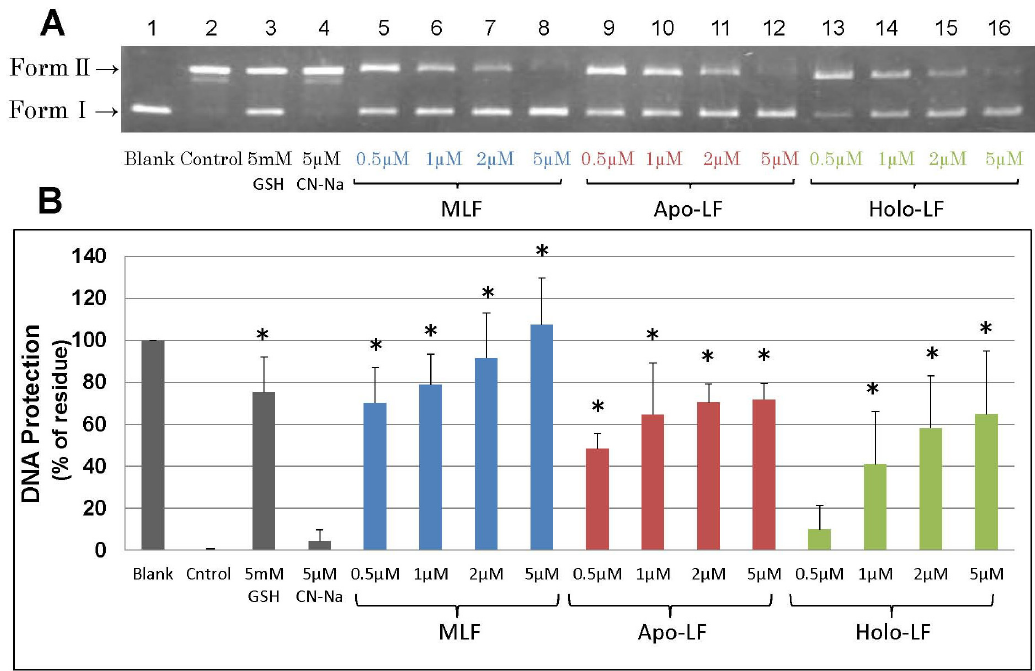
Figure 1. Dose response and efficacy of LFs on DNA damage by •OH generated by the Fenton reaction. Electrophoresis of plasmid DNA using an agarose gel (1.0%) was performed after exposure to •OH generated by the Fenton reaction. Experiments were conducted for 20 min at 37 °C, using iron and H O (using final concentrations of 50 μ L 2 2 O , 5 μ M FeCl , 25 μ M EDTA, and 10 μ M ascorbic acid). ( A ) Lane 1, PBS, 50 μ M H 2 2 3 plasmid (Blank); lane 2, Fenton reaction mixture plus plasmid (Control); lane 3, Fenton reaction mixture plus plasmid and 5 mM GSH; lane 4, Fenton reaction mixture plus plasmid and 5 μ M Casein sodium (CN-Na); lane 5, Fenton reaction mixture plus plasmid and 0.5 μ M MLF; lane 6, Fenton reaction mixture plus plasmid and 1 μ M MLF; lane 7, Fenton reaction mixture plus plasmid and 2 μ M MLF; lane 8, Fenton reaction mixture plus plasmid and 5 μ M MLF; lane 9, Fenton reaction mixture plus plasmid and 0.5 μ M apo-LF; lane 10, Fenton reaction mixture plus plasmid and 1 μ M apo-LF; lane 11, Fenton reaction mixture plus plasmid and 2 μ M apo-LF; lane 12, Fenton reaction mixture plus plasmid and 5 μ M apo-LF; lane 13, Fenton reaction mixture plus plasmid and 0.5 μ M holo-LF; lane 14, Fenton reaction mixture plus plasmid and 1 μ M holo-LF; lane 15, Fenton reaction mixture plus plasmid and 2 μ M holo-LF; and lane 16, Fenton reaction mixture plus plasmid and 5 μ M holo-LF; ( B ) DNA protection (%) was calculated based on the densitometry of EtBr-stained bands (Form I) against blank (non-treated plasmid DNA, lane 1) band intensities under the reaction conditions described in A (lanes 2–16). Data are presented as the mean ± S.D. of triplicate determinations. * p < 0.05 compared to the control value was considered as a statistically significant difference